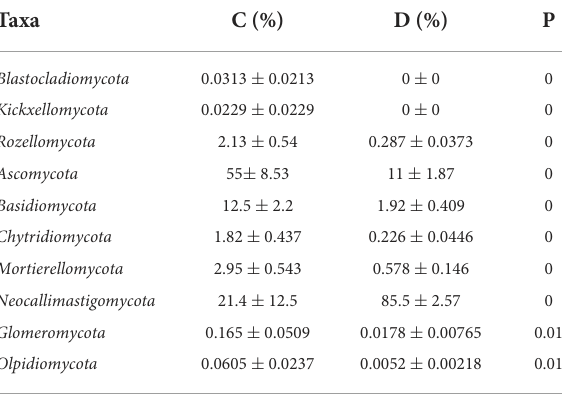
TABLE 2 Comparative analysis of differential fungal phyla between control and diarrheic